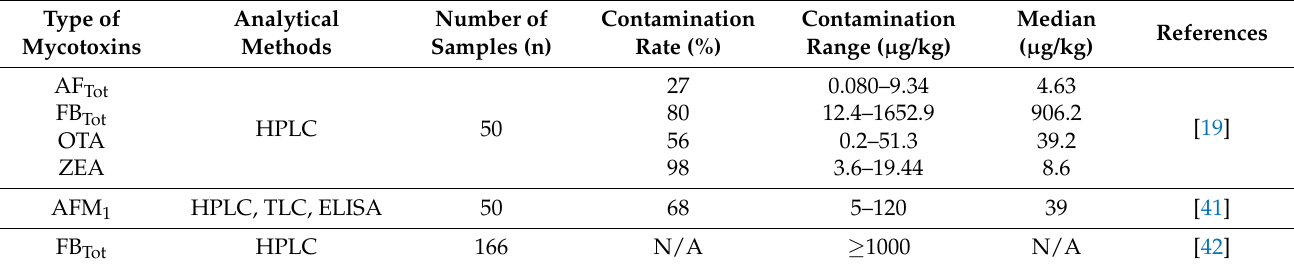
Table 1. Mycotoxin contamination of cereals from subsistence